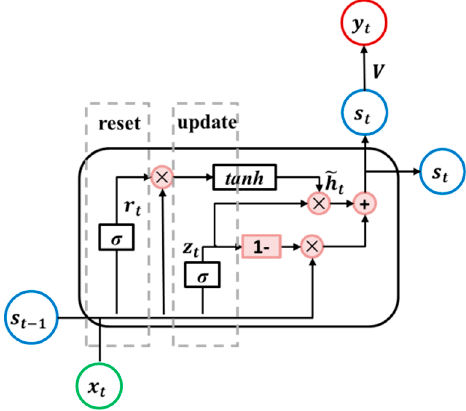
Figure 5. Diagram of the gated recurrent unit RNN (GRU RNN) unit.